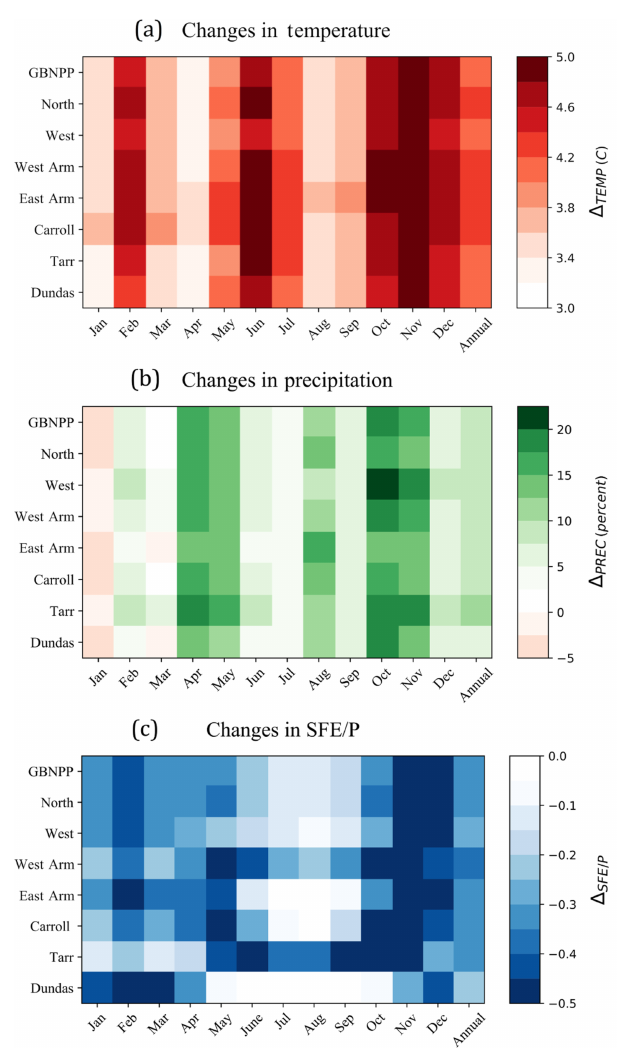
Figure 3. Temperature and precipitation changes. (a) Monthly and annual temperature changes ( ◦ C) from historical (1979–2015) val- ues by watershed, based on temperature anomalies from the pro- jection scenario (2070–2099). (b) Monthly and annual precipita- tion changes (%) from historical (1979–2015) values by watershed, based on the projection scenario (2070–2099). (c) Monthly and an- nual snowfall water equivalent to precipitation (SFE /P ; unitless) changes from historical (1979–2015) values by watershed, based on the projection scenario (2070–2099). Color heat maps are used to visualize the changes in temperature and precipitation because they efficiently communicate hundreds of values in a compact and clear